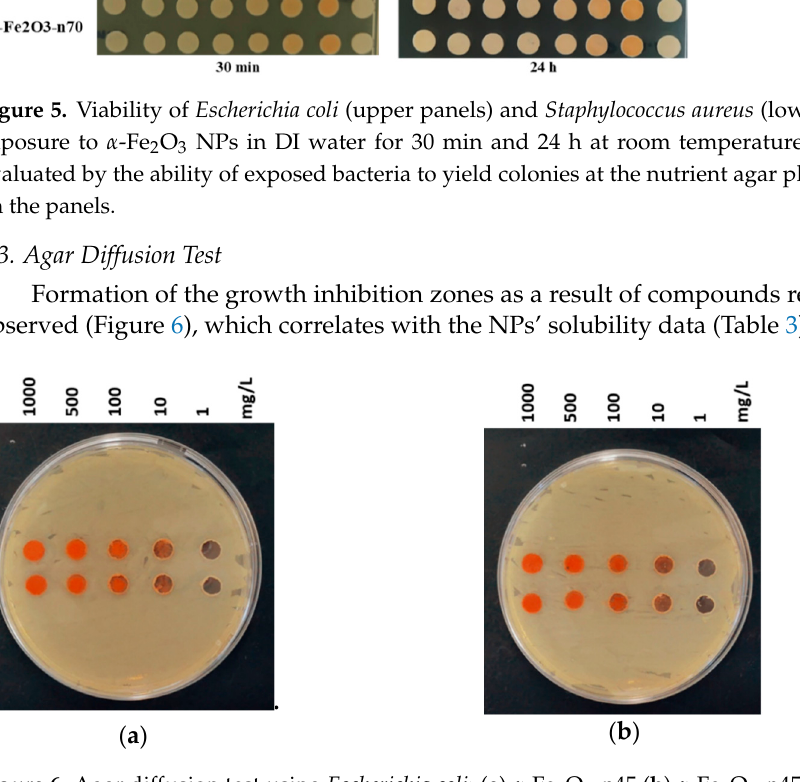
Figure 6. Agar diffusion test using Escherichia coli : ( a ) α -Fe 2 O 3 - p 45 ( b ) α -Fe 2 O 3 - n 45 . Exposure time 24 h, temperature 30 °C, Mueller–Hinton agar medium (MHA). Agar diffusion test images for Staphylococcus aureus can be found in the Supplementary Material (Figure S2).